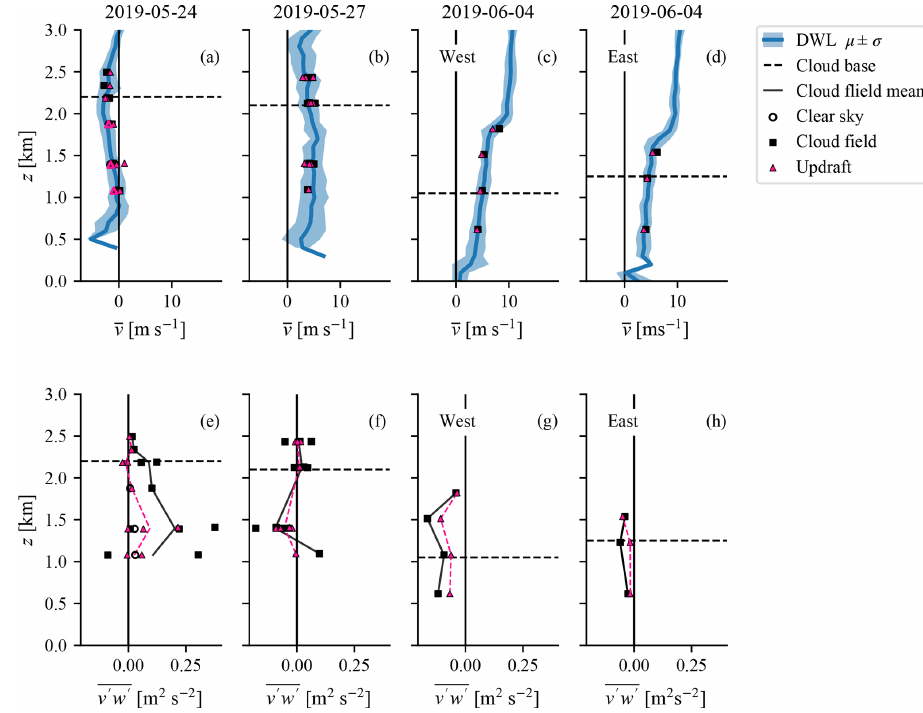
Figure 9. Same as Fig. 8, but for v and v (cid:48) w (cid:48) . The v axis is positive northward.